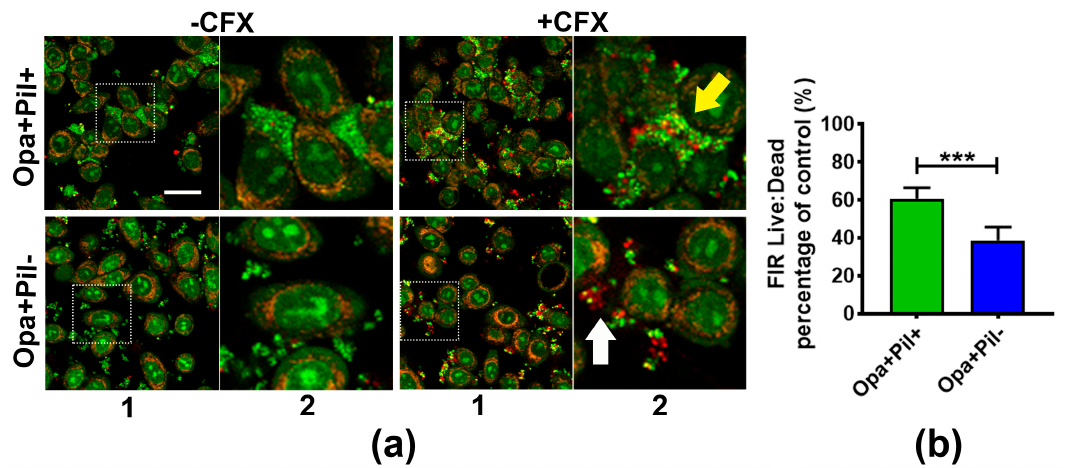
Figure 3. Survival and distribution of GC aggregates on human cervical epithelial cells. MS11Opa+Pil+ or MS11Opa+Pil- were inoculated and incubated with ME180 cells for 6 h. ( a ) GC- epithelial cell co-cultures were treated with 1 µg/mL ceftriaxone (+CFX) or mock treated (-CFX) for 2 h, stained with Live/Dead BacLight stain for visualizing live (Green) and dead (Red) GC, and analyzed using a confocal fluorescence microscope. The images shown in panel (1) reflect the overall distribution of cells and the image in panel (2) is an enlargement of the inset, shown as a dotted box. Yellow arrow, a large aggregate of Opa+Pil+ GC; White arrow, a small aggregate of Opa+Pil- GC. ( b ) The live to dead GC ratios were quantified by the FIR of green to red staining. The average ratio (±SD) was obtained from >30 images of three independent experiments. *** p < 0.001; ** p < 0.01; * p < 0.05. Scale bar, 30 µm.